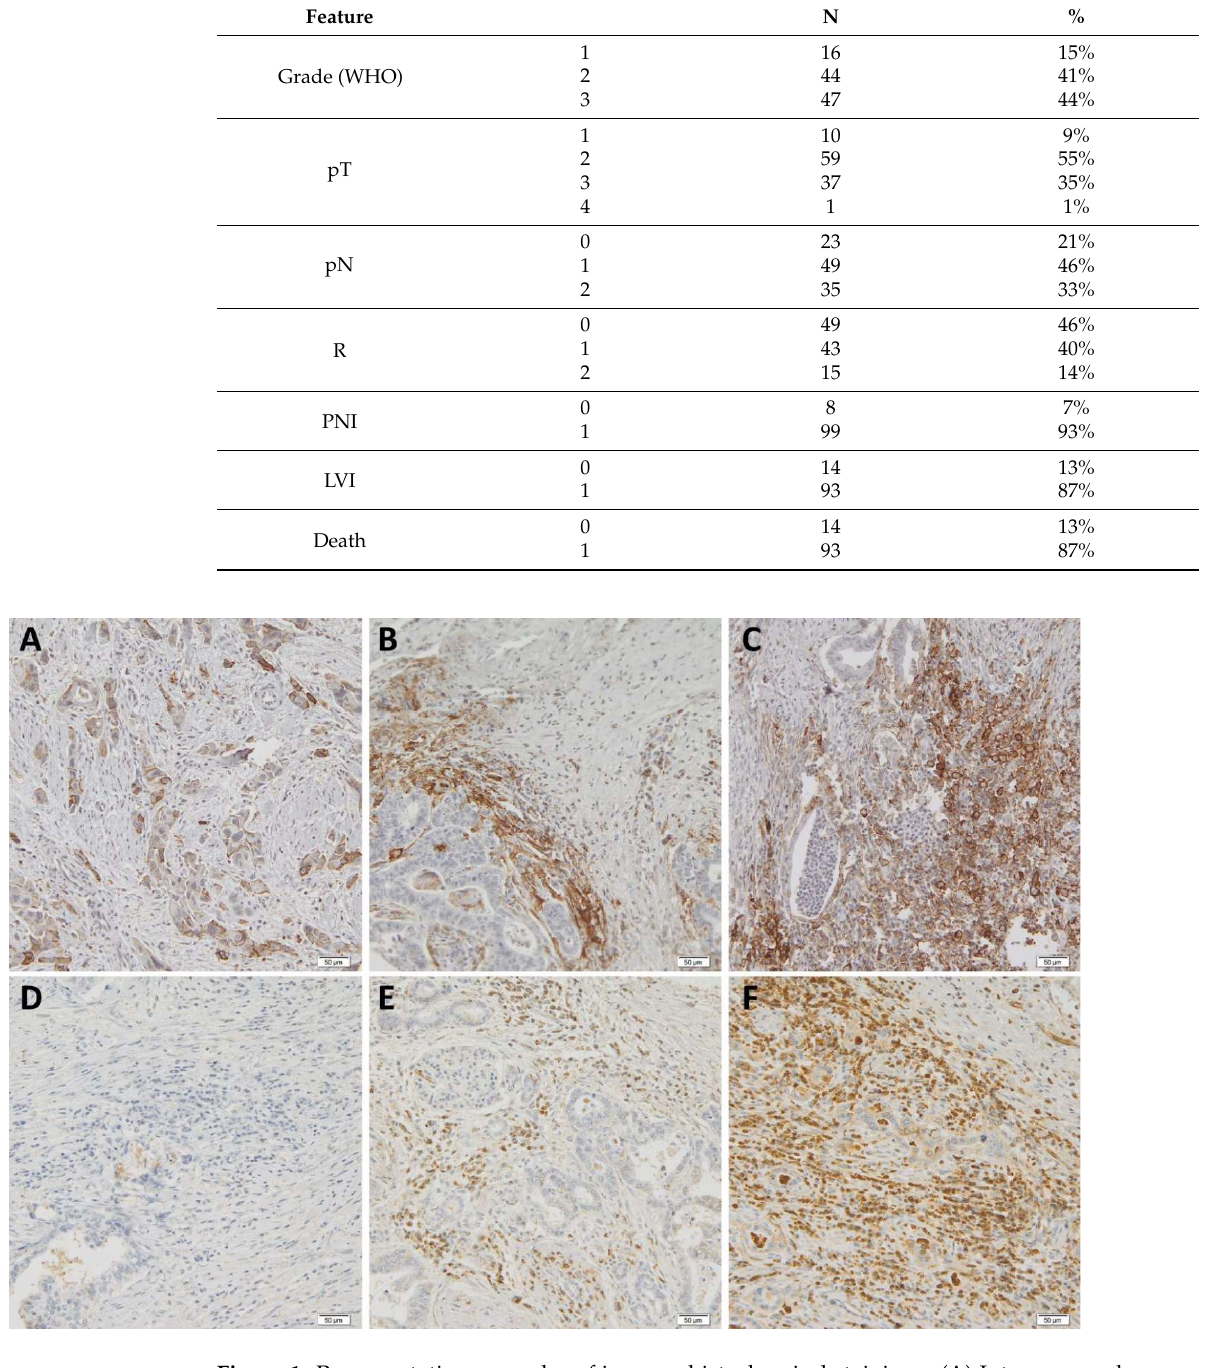
Table 2. Median and interquartile (IQR) values for markers of systemic inflammation: neutrophil- to-lymphocyte ratio (NLR), platelet-to-lymphocyte ratio (PLR), and monocyte-to-lymphocyte ratio (MLR).